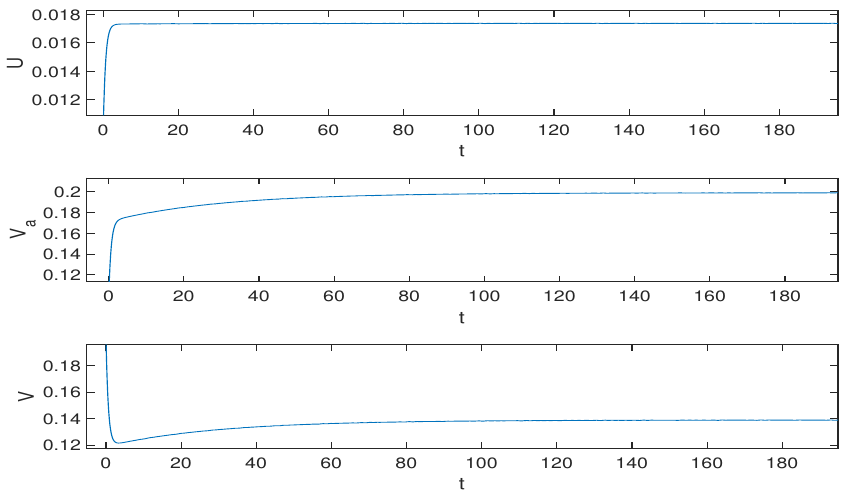
Figure 6. When τ =0, the equilibrium P of system (1) is locally asymptotically stable. Substituting these parameters’ values into Equation (7), we obtain c 0 ≈ − 0.000081, c 1 ≈ 0.254617, c 2 ≈ 1.033500. By derivation of Equation (7), ∆ ≈ 1.217044, ˜ z 1 ≈ − 0.505131, ˜ z 2 ≈ − 0.872863, we further calculate h ( ˜ z ) ≈ 0.006119, h ( ˜ z ) ≈ − 0.099943. It satisfies as- 2 1 sumption (H4) . Using MATLAB, according to Equations (7) and (8), we obtain ω 1 ≈ ( 0 ) 0.017865, Q 0 ≈ 0.62373, P 0 ≈ 0.78164, τ